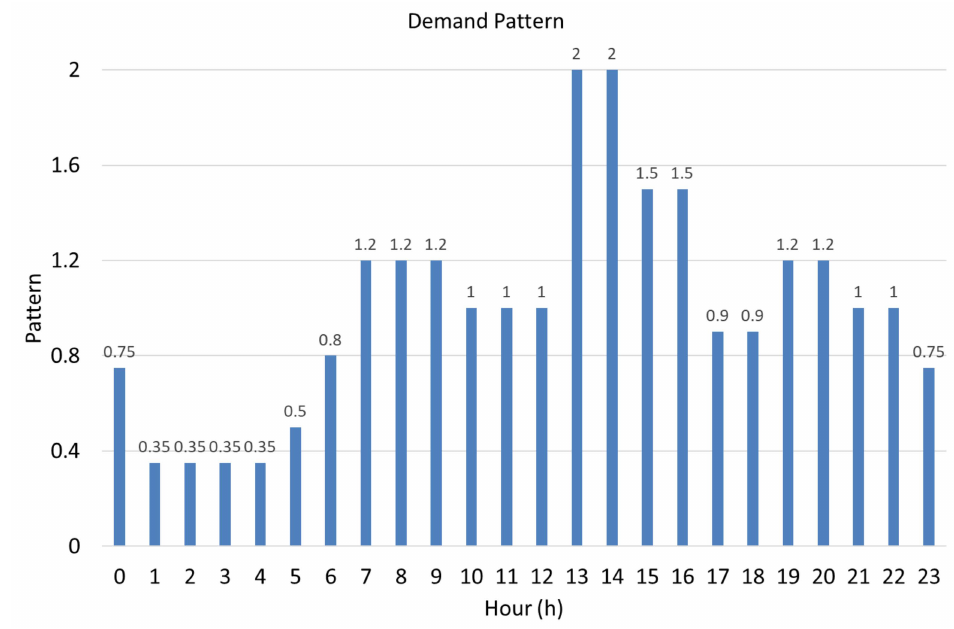
Figure 3. Demand Patter for TF-Network and CAT-Network.